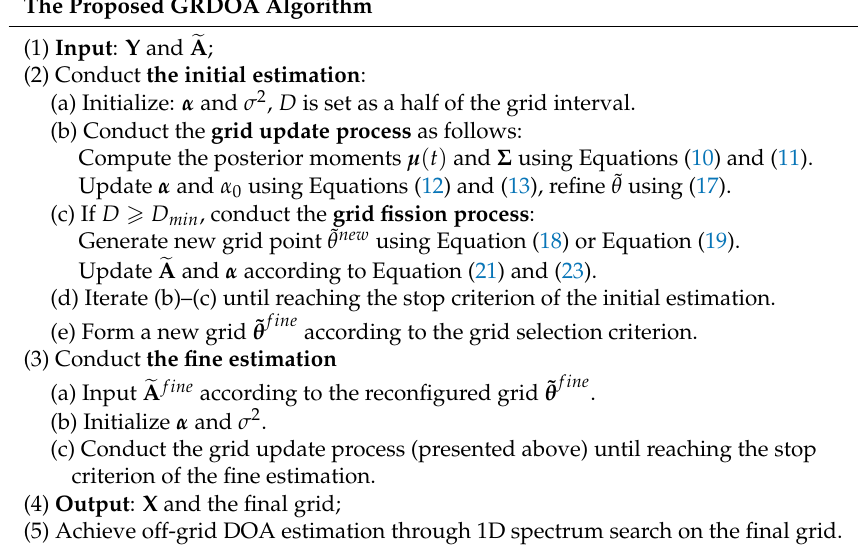
Table 1. Operating instruction of